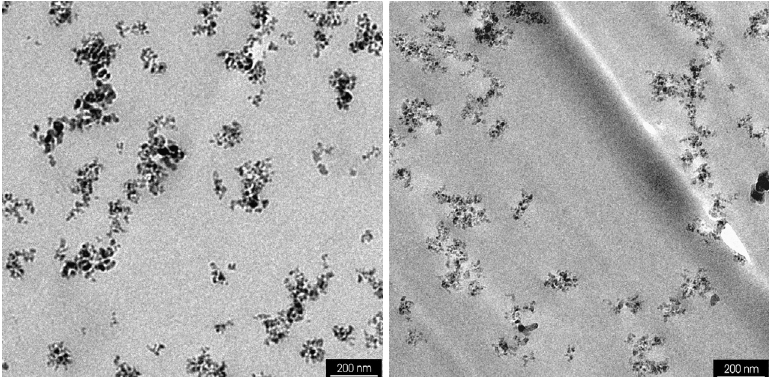
Figure 3. Transmission electron microscopy (TEM) micrographs of Aerosil ® R8200, dispersed in a methylmethacrylate (MMA) using a high speed stirrer (left) or a high pressure homogenizer (right), after solidification to polymethylmethacrylate (PMMA).